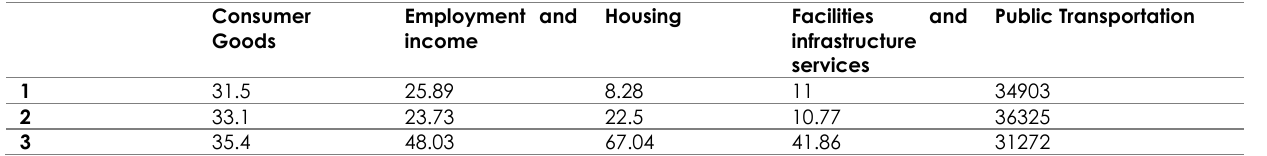
Table 1. Economic Data Matrix.